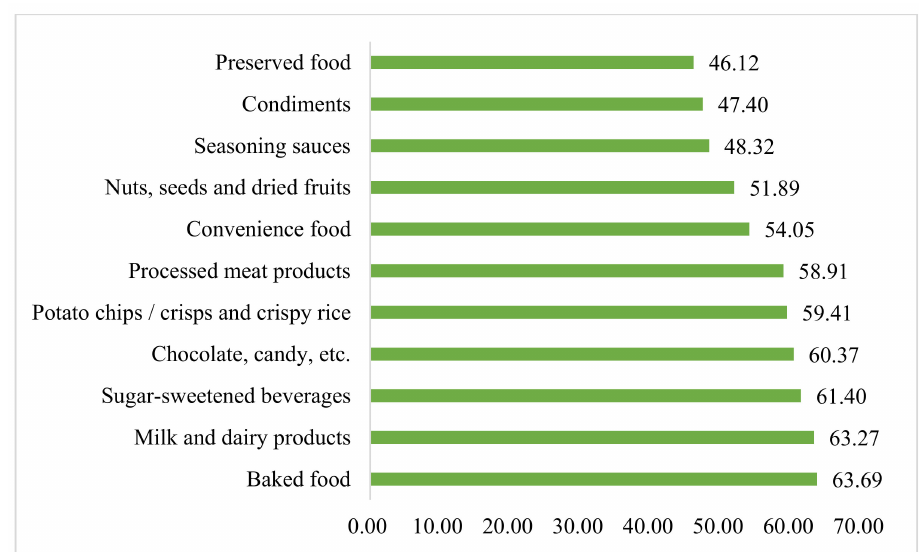
Figure 3. The preference to identify FOPL on 11 categories of prepackaged food